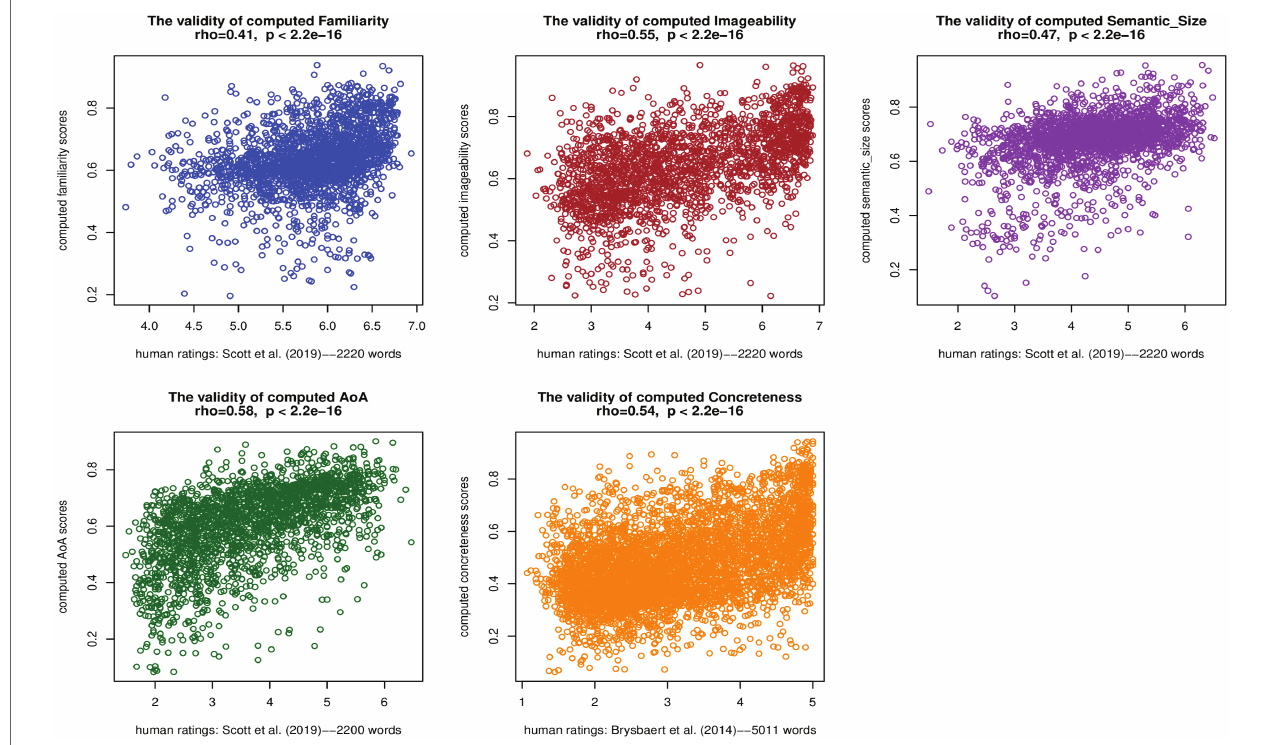
FIGURE 1 | Spearman’s correlations between aggregated computed LPP dimension scores and human ratings in the